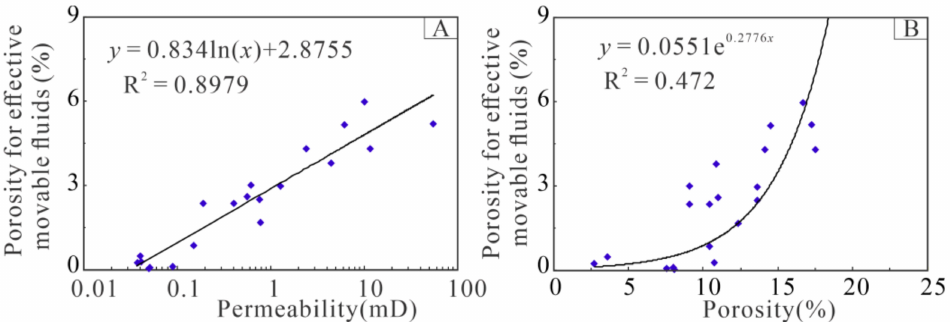
Figure 11. Relationships between porosity for effective movable fluids and petrophysical